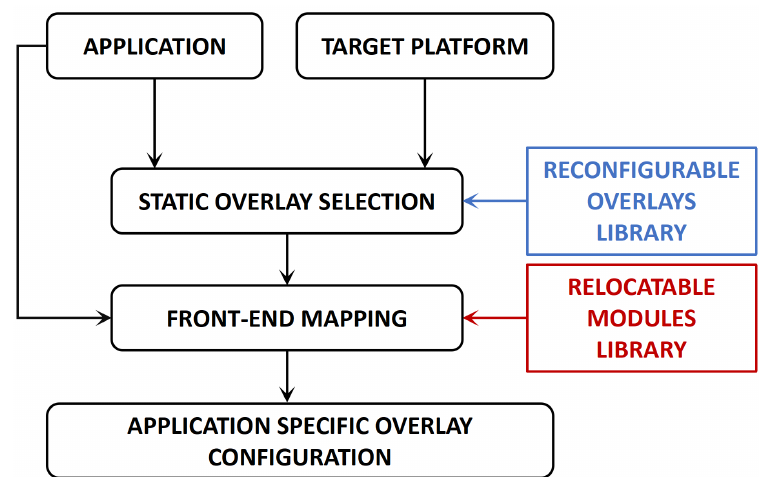
Figure 7. VCGRA with relocatable partitions—front-end mapping design flow